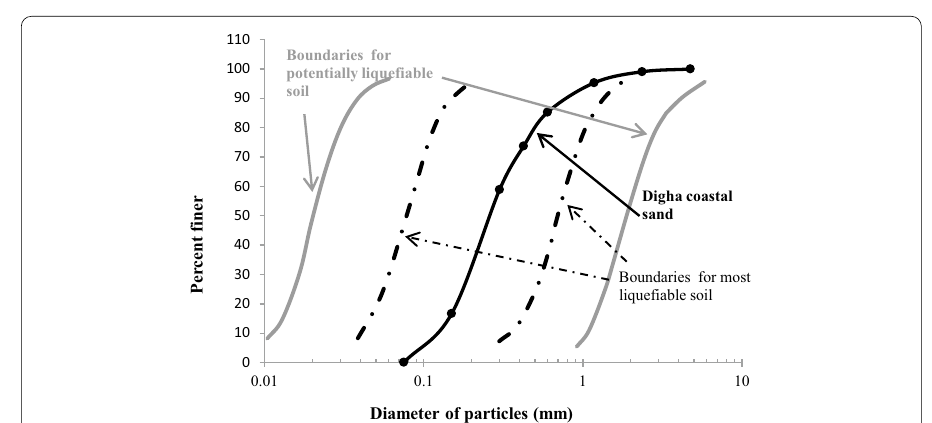
Fig. 2 Grain size distribution curve of Digha sand with liquefiable